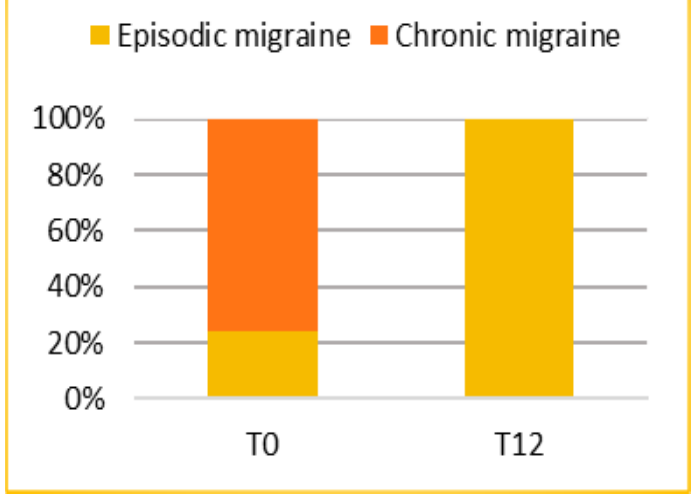
Figure 1. Conversion from chronic to episodic migraine after 12 months of treatment. In parallel with the reduction in the number of days with migraine, treatment with Erenumab was also effective in reducing the number of days of consumption of